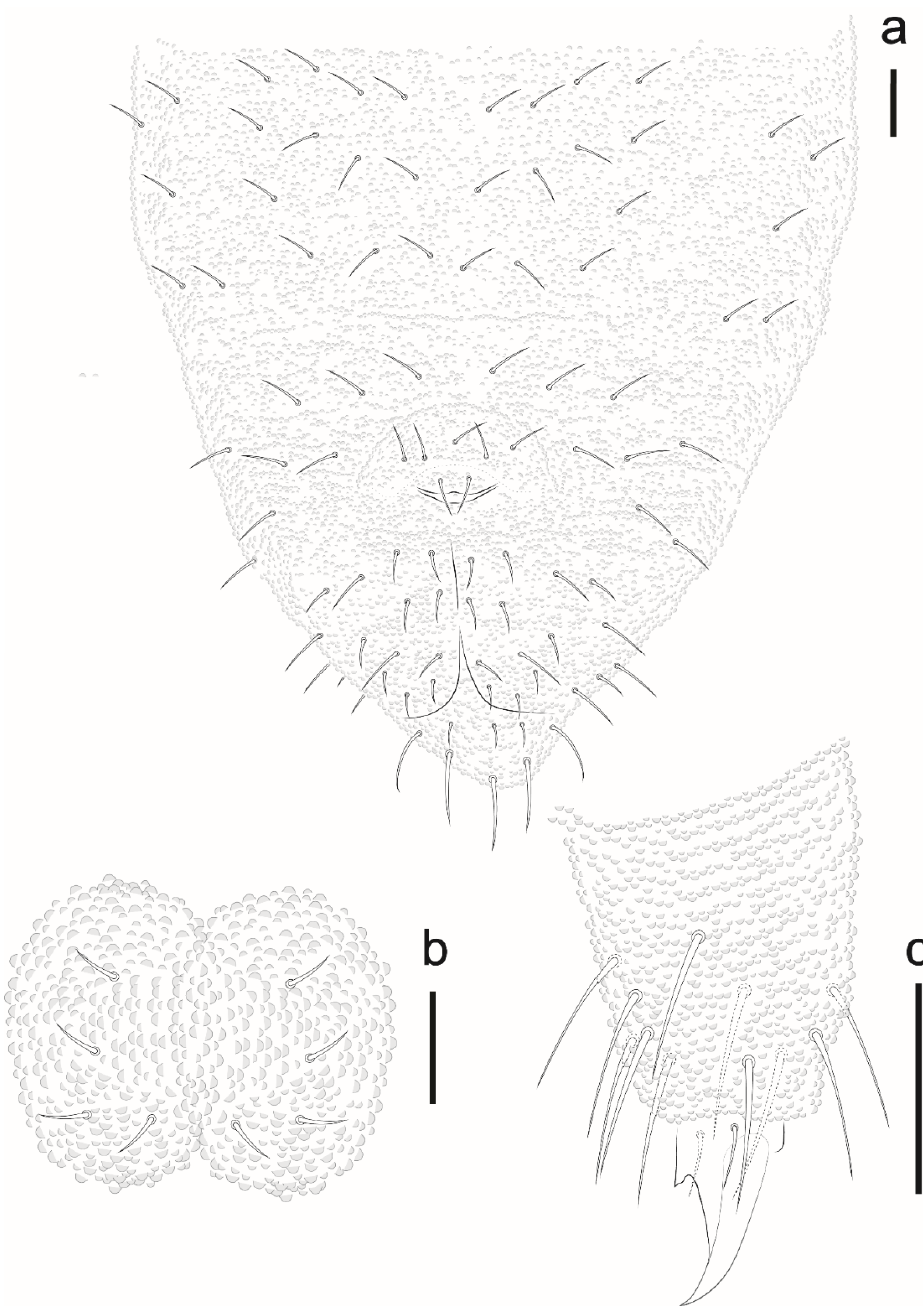
Figure 23. Willemia insularum sp. nov. ( a ) ventral view of Abd II–VI, scale bar: 10 µm. ( b ) ventral tubes, scale bar: 20 µm. ( c ) Tita III, scale bar: 20 µm. Table 8. Data matrix of 52 characters coded for Willemia species recorded in Brazil. Character numbers correspond to the characters listed in [26]. Polymorphic characters coded as follow [23], 0 or 1 = a; 0 or 2 = b; 0, 2 or 3 = c. “?”—missing date.